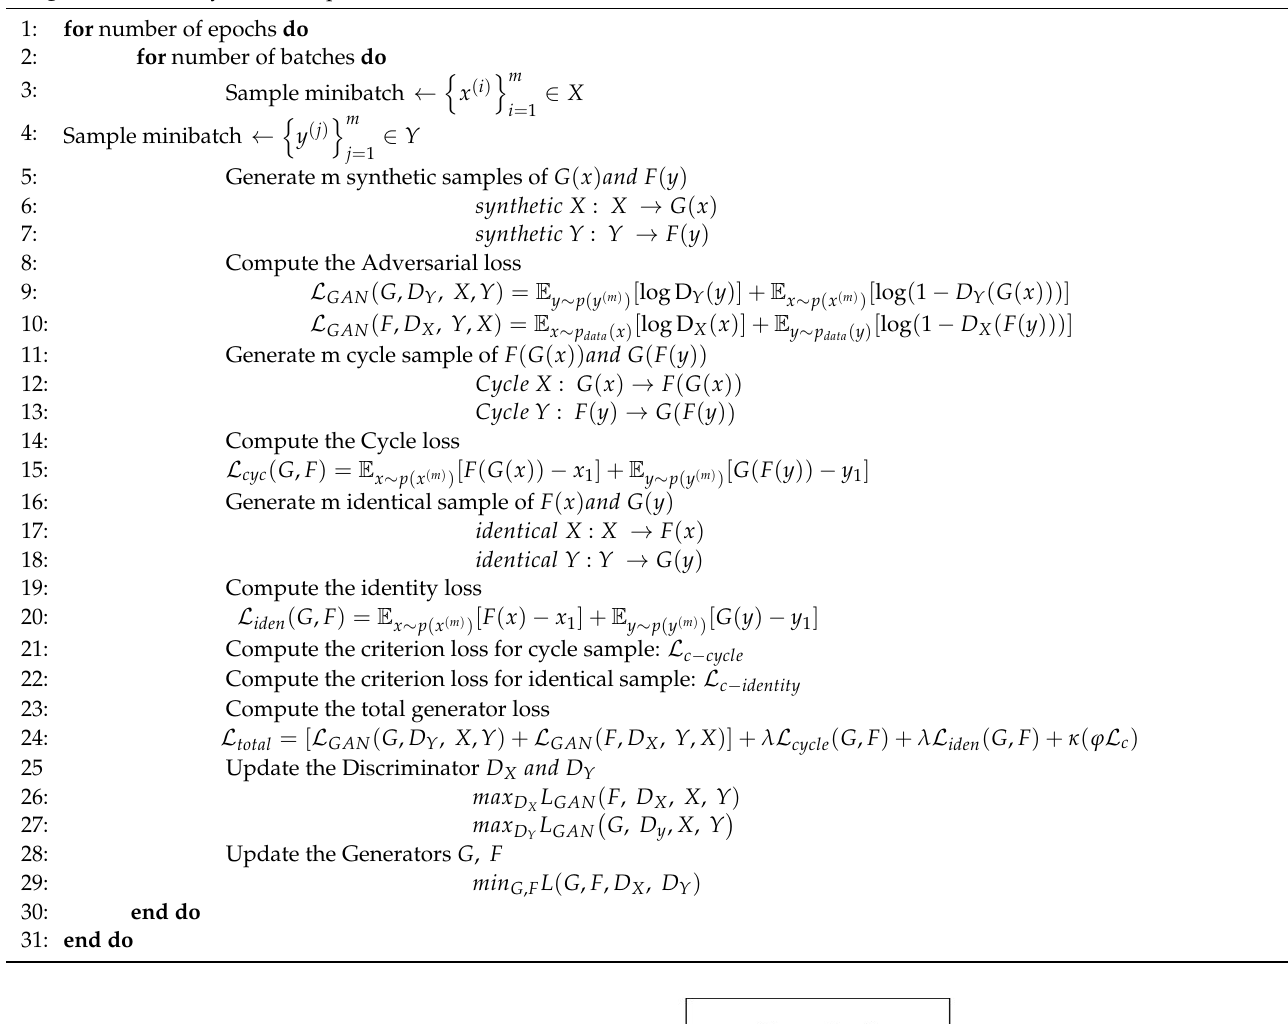
Algorithm 1. Ad CycleGAN Optimization